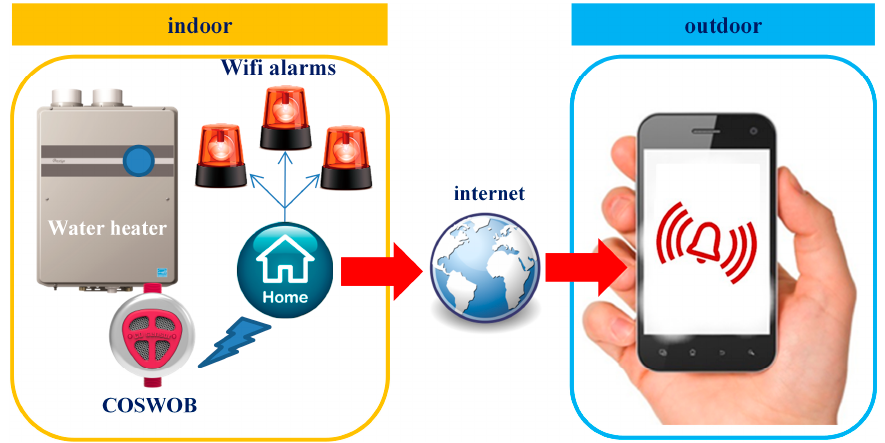
Figure 2. Schematic of the key devices in our strategy for avoiding carbon monoxide (CO) poisoning happen.